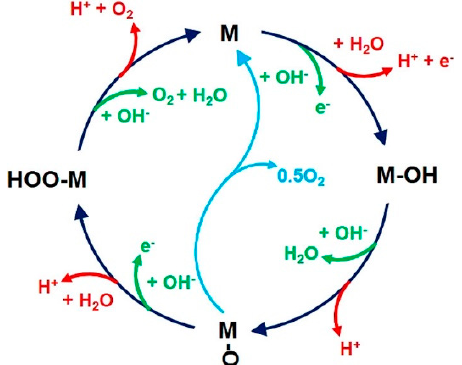
Figure 2. The cyclic diagram of OER. The red line (alkaline conditions) and green line (acidic conditions) indicate the products generated by each step when the OER takes place in different media. The dark blue line indicates the reaction process involving the formation of peroxide intermediate while the light blue represents the process by which oxygen is produced when two adjacent M-O intermediates react directly. Copied with permission from [31]. Copyright © 2018, American Chemical